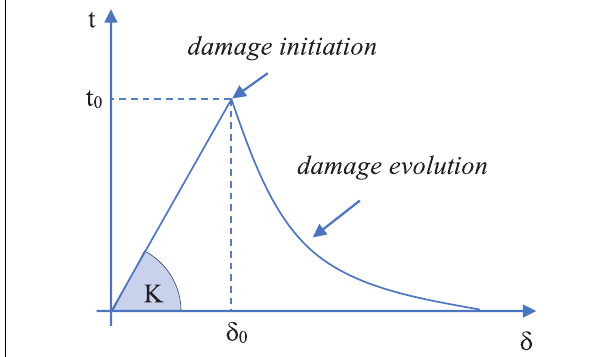
FIGURE 2 | Cohesive model.